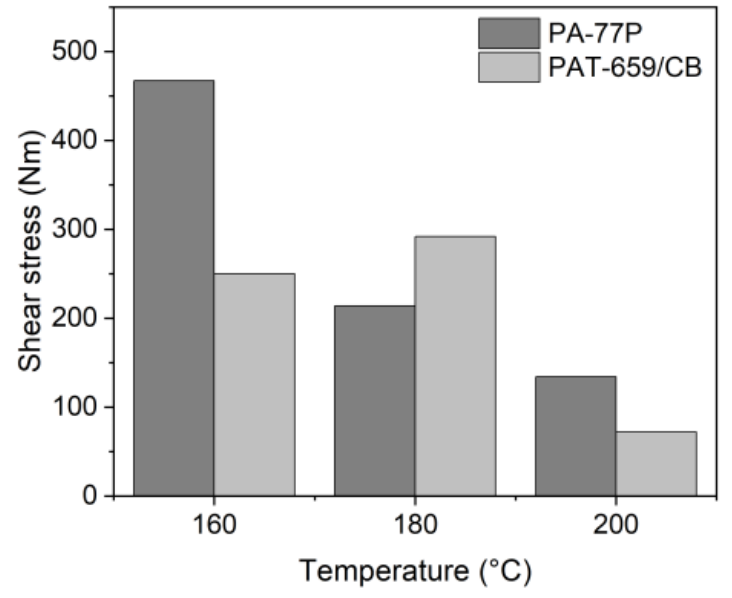
Figure 13. Shear stress values for the yield points for PEG60/PMMA40 (PEG 8000) applying the surfactants PAT-77P and PAT-659/CB at different temperatures (solid load 65 vol%).